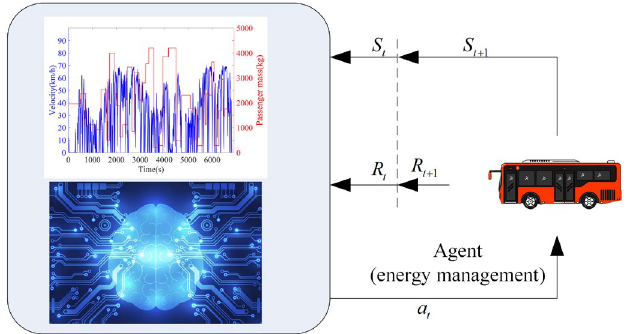
Figure 7. The principle of the RL-based energy management.